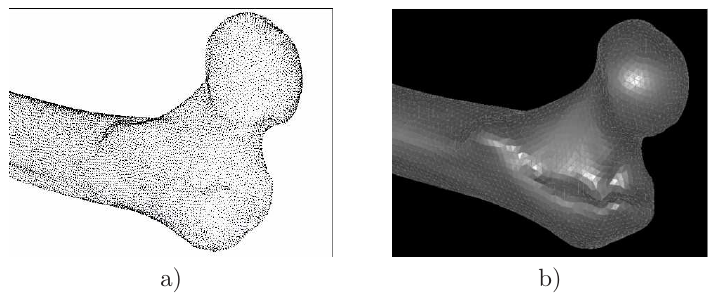
Figure 4. Complete point cloud with 1.5 million points and the final triangle surface